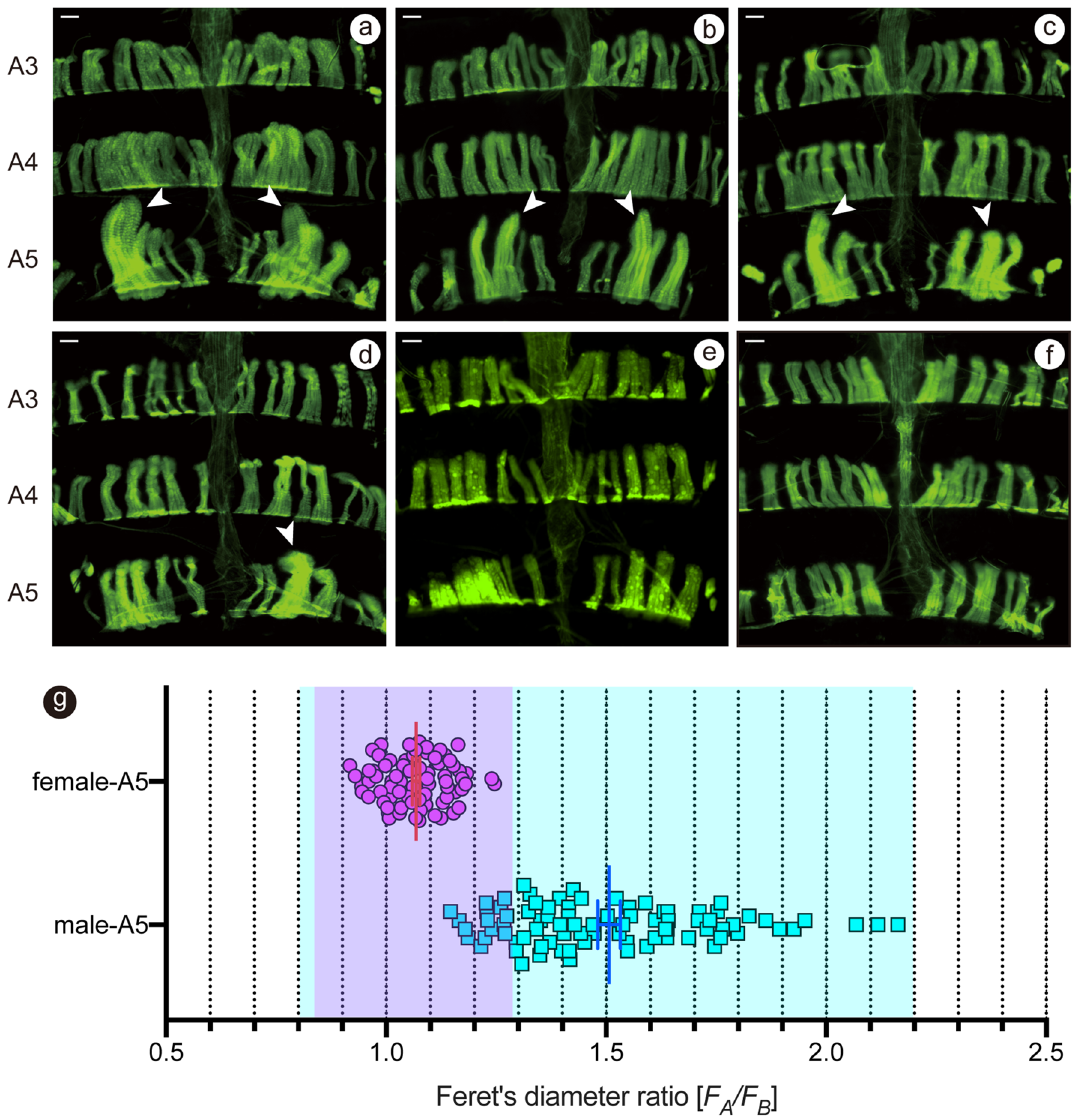
from A5. ( g ) The scatter plot shows the distribution of mean F A /F B values as compared between the male and female. Each symbol represents the values estimated for a hemi-segment. The red and blue long lines represent the mean values for female and male values, respectively. The short bar represents the SEM. The blue and pink areas in the graph indicate the 99% confidence intervals (mean ± 3 × SD values) of the muscle size for males and females,